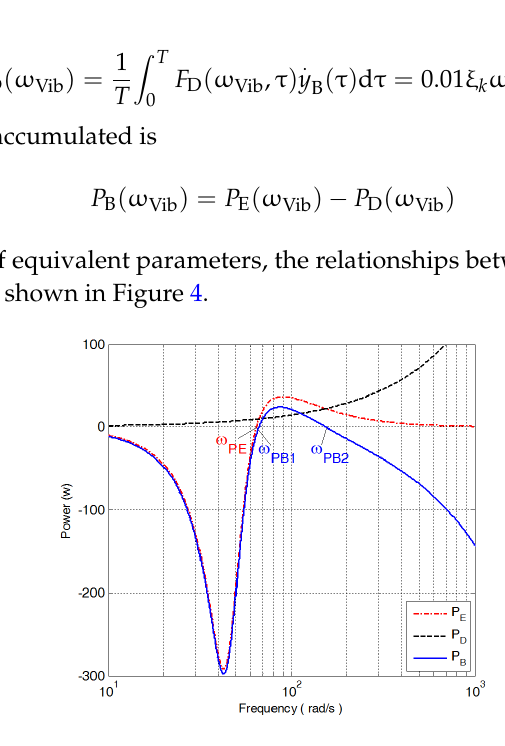
Figure 4. The averaged